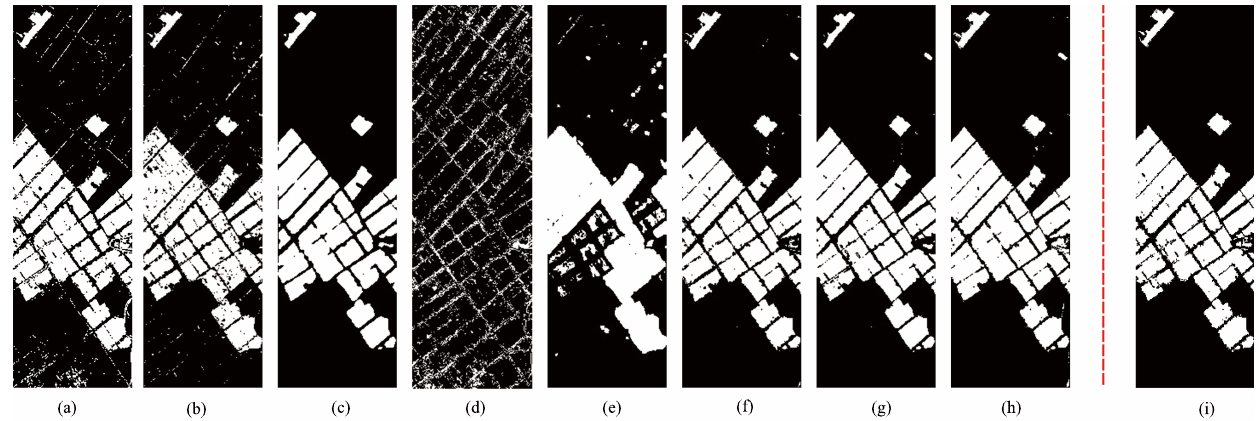
Figure 11. The change map results of different methods on the Irrigated Agriculture Dataset. ( a ) CVA. ( b ) SVM. ( c ) GETNET. ( d ) DSFANet. ( e ) WCRN. ( f ) Without FRL. ( g ) Without PS 2 A. ( h ) TFR-PS 2 ANet. ( i ) Ground truth.